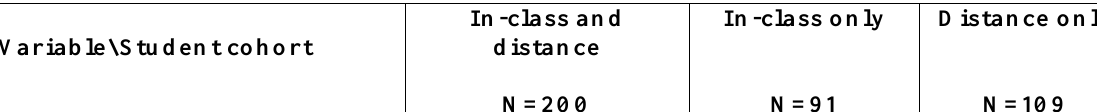
Variable\Student